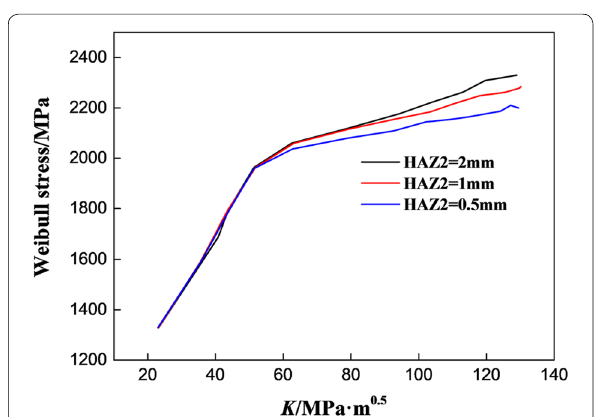
Figure 9 Effect of HAZ2 width on Weibull stress in HAZ2 under mismatch of M 1.2 =